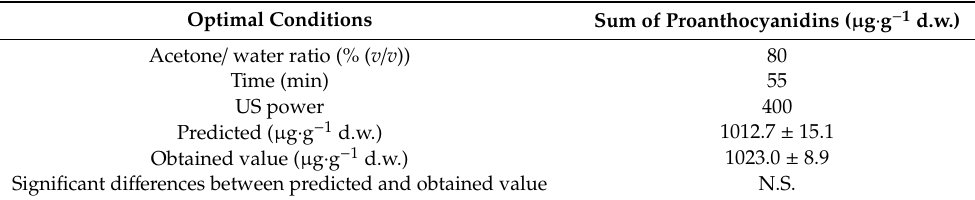
Table 5. Optimal conditions for sonotrode